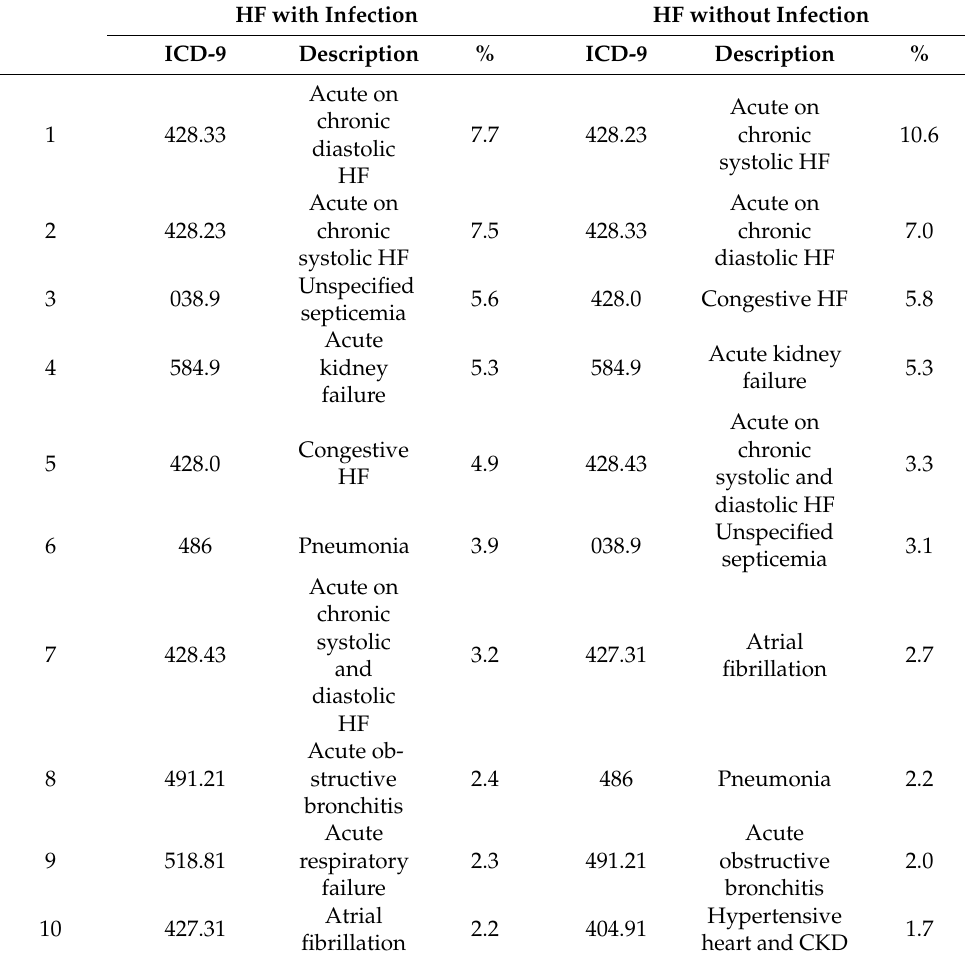
Table 4. Ten most frequent primary diagnoses at 30-day